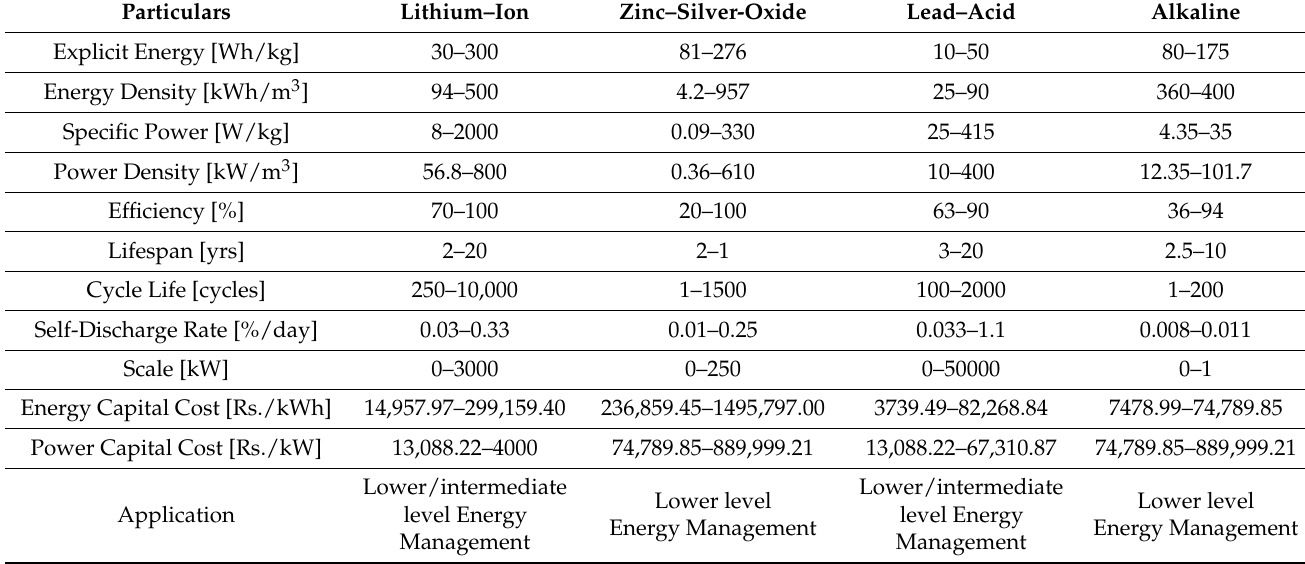
Table 3. Diverse battery storage system general specification.